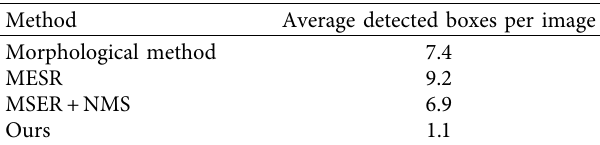
Table 1: Comparison of text detection results.